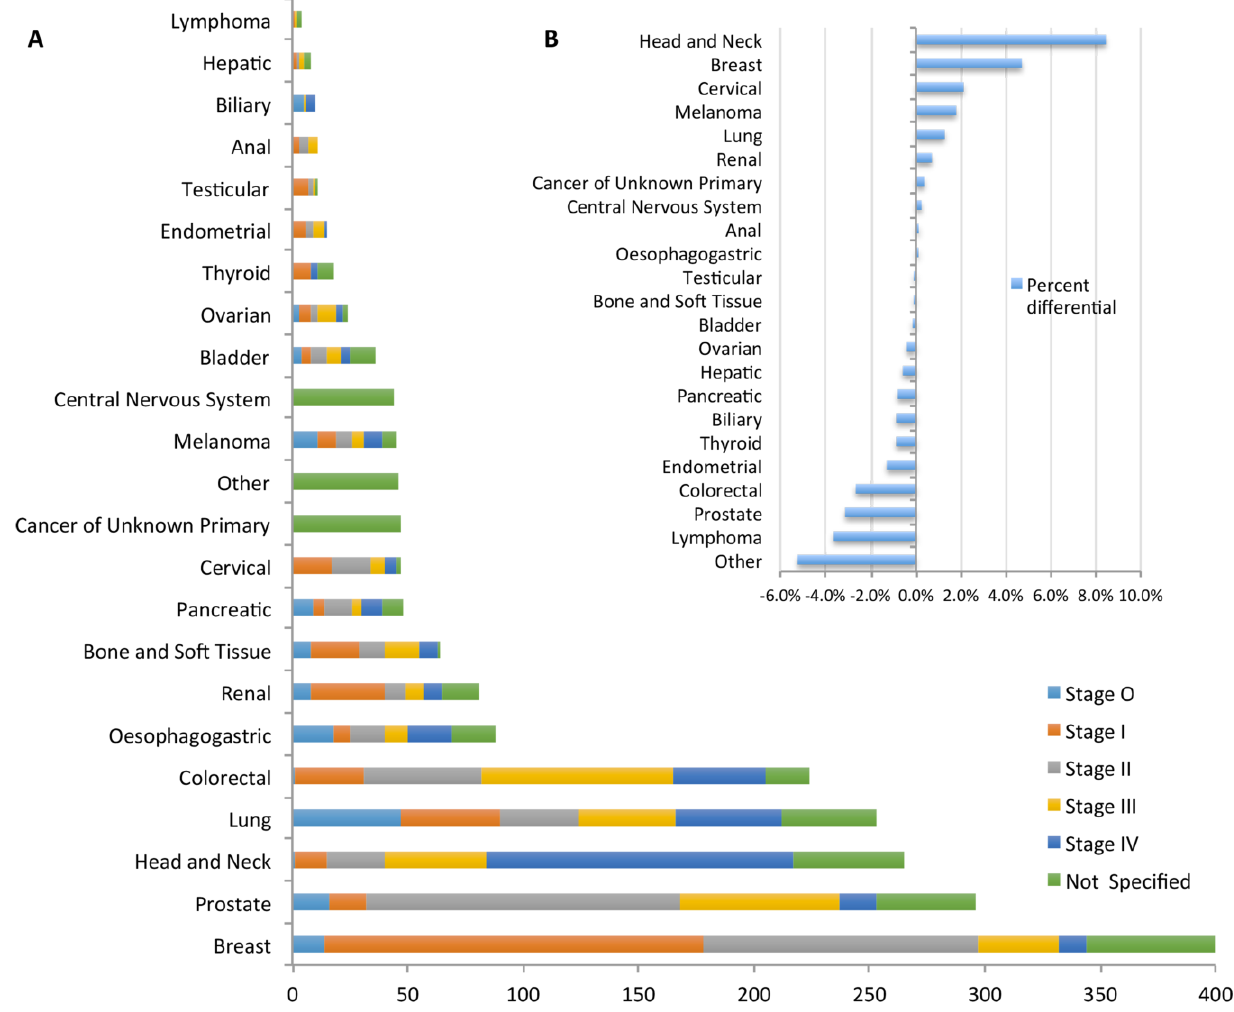
Figure 2. ( A ) Patient diagnoses in the Cancer 2015 Cohort separated into different tumour histo-types and clinical stage (as colour labelled in legend). Note: A minority of patients (n = 50) have tumours that fall into less common cancers such as skin, vulvovaginal, penile and urothelial cancers; ( B ) The variation between the Cancer 2015 Cohort accrual rate, expressed as a percentage of total cancers and separated by cancer histotype, compared with the VCR 2011 census of cancer incidence in Victoria (solid-cancers only; removal of paediatric and haematological cancers; Note: Melanoma incidences represent advanced stages only). Positive percentage differential reflect recruitment of patients with stated cancer histotype greater than published Victorian